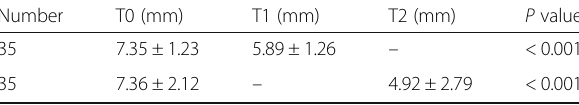
Table 1 Summary of bone defect in patients without